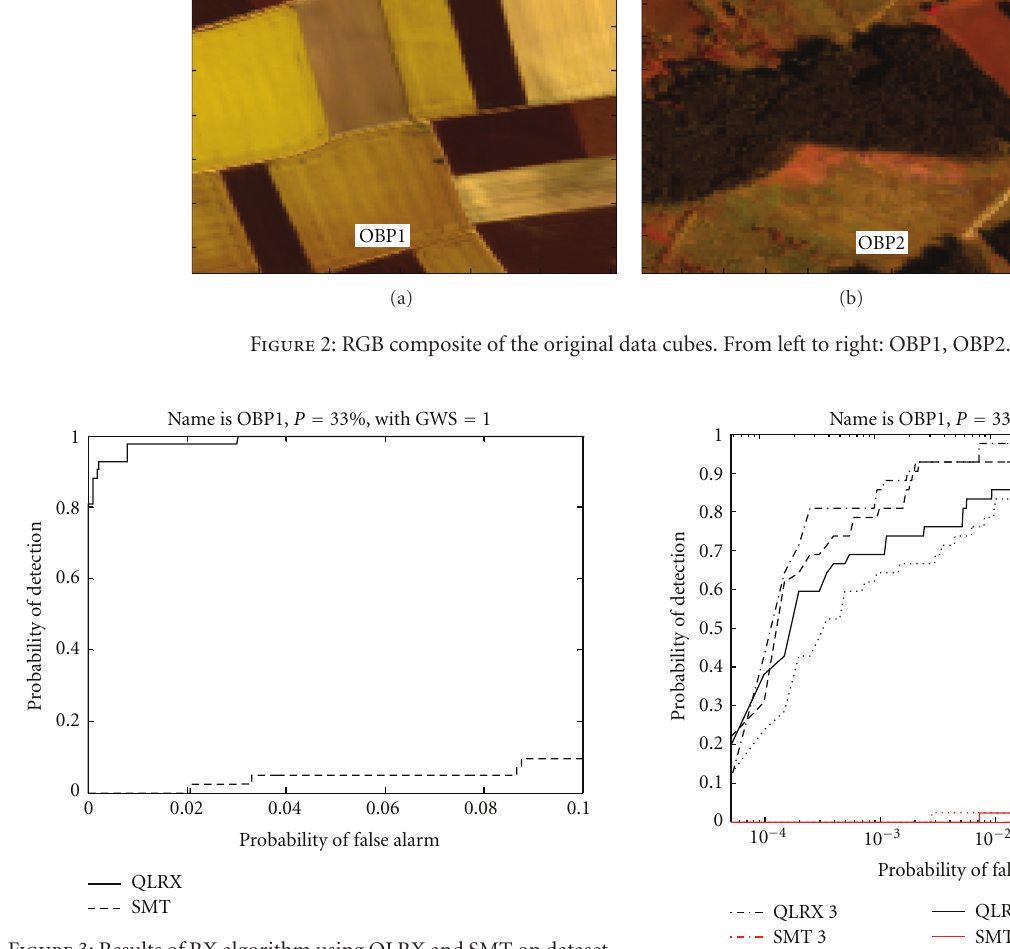
Figure 3: Results of RX algorithm using QLRX and SMT on dataset OBP1 with the stated OWS = 3 and GWS = 1.